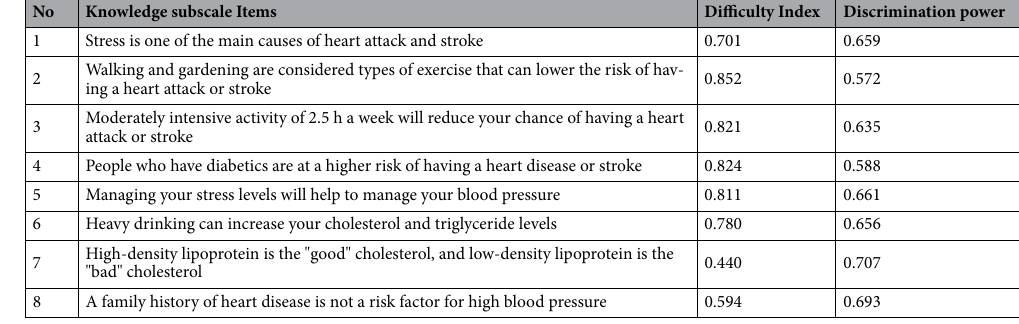
Table 4. Item Statistic of Knowledge subscale of ABCD-C ( N = 318, M ± SD ).